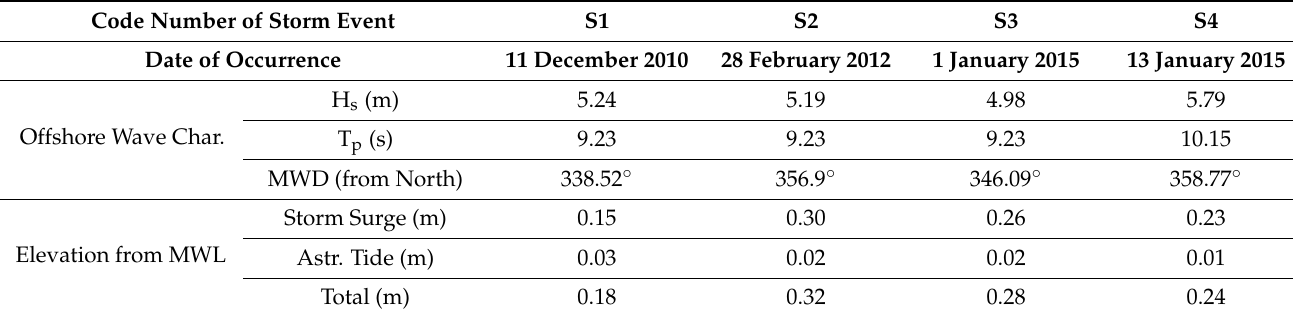
Table 1. Sea-state data during past flood events in Rethymno, obtained from open databases. Code Number of Storm Event S1